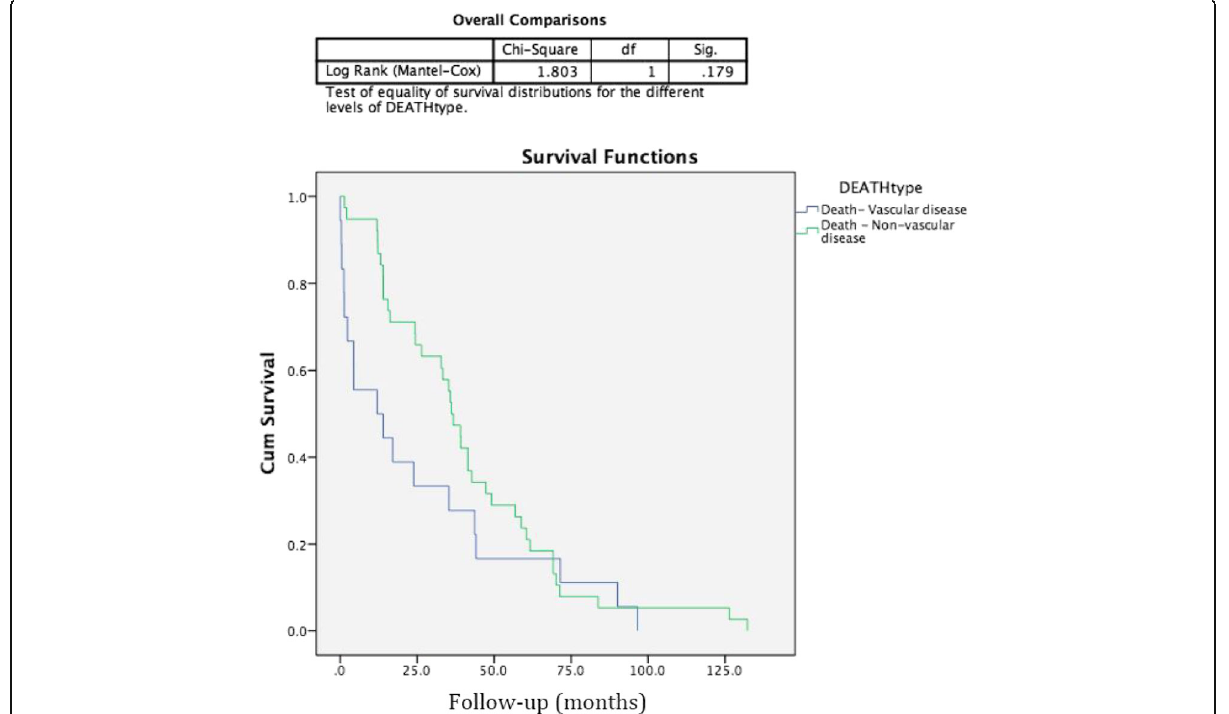
Fig. 1 Survival curves for vascular and non vascular deaths